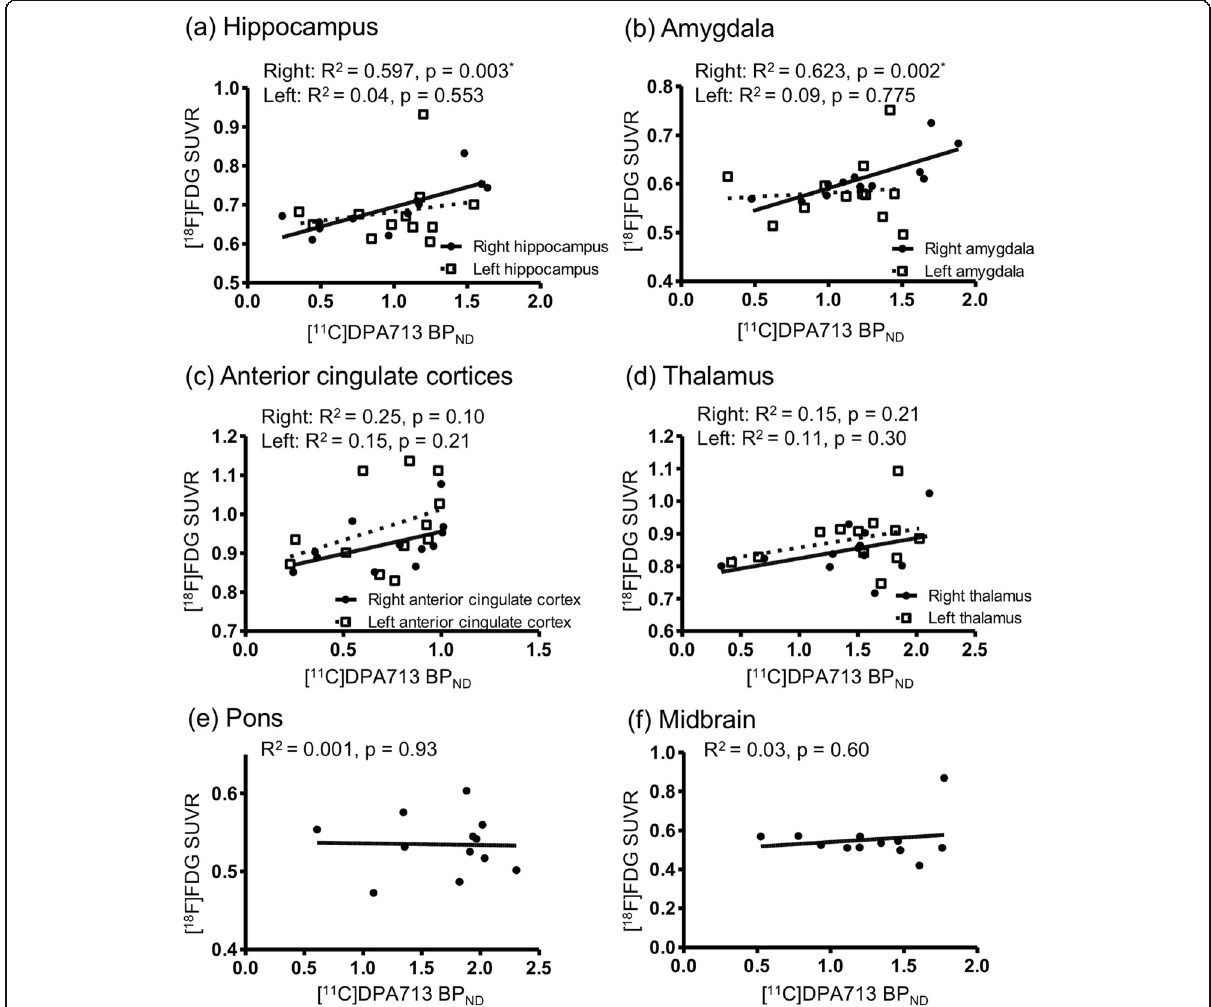
Fig. 3 Correlations between [ 11 C]DPA713 binding potential and [ 18 F]FDG standardized uptake value ratio. In the right hippocampus ( a ) and the right amygdala ( b ), [ 11 C]DPA713 binding potential (BP ND ) and [ 18 F]FDG standardized uptake value ratio (SUVR) were significantly positively correlated ( p < 0.05, corrected for multiple comparisons). The anterior cingulate cortex ( c ) and thalamic regions ( d ) tended to show positive correlations between [ 11 C]DPA713 BP ND and [ 18 F]FDG SUVR. The pons ( e ) and midbrain ( f ) shows no clear correlations between [ 11 C]DPA713 BP ND and [ 18 F]FDG